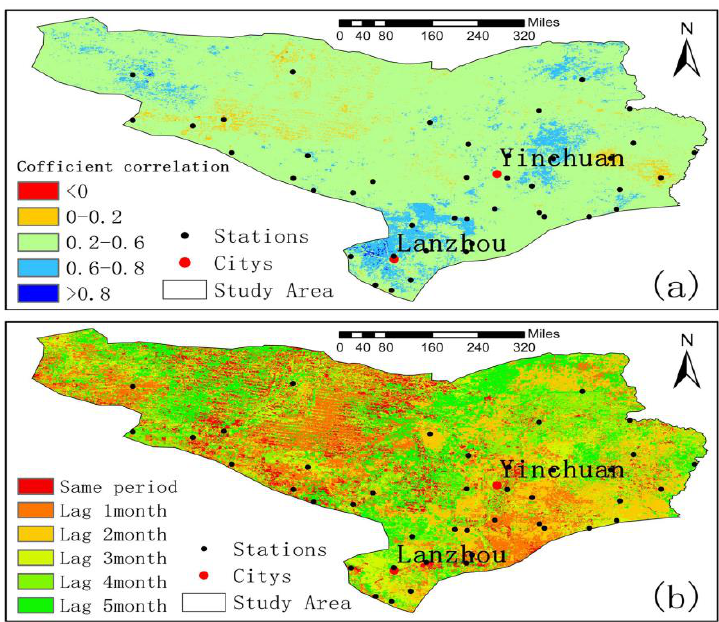
Figure 4. Spatial distribution of maximum cross-correlation ( a ) between NDVI and humidity index and time-lag response ( b ) in the Menggan region.